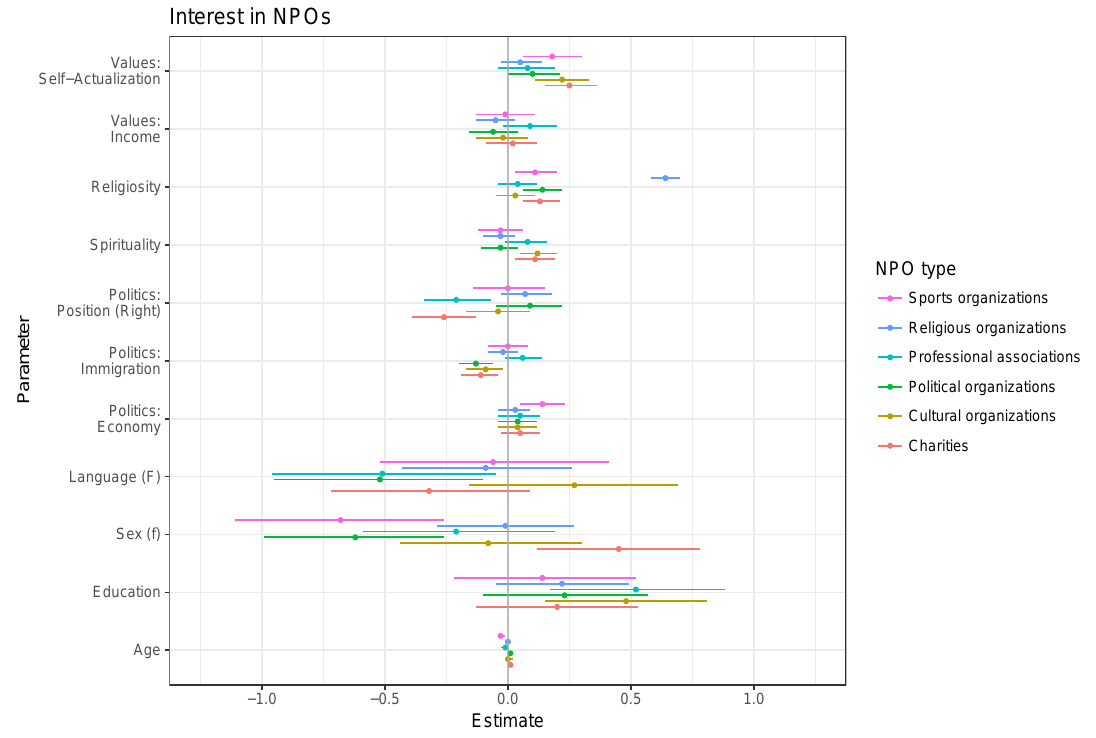
Figure 1. Parameter estimates for the six models with interest in NPOs as the response (dependent)